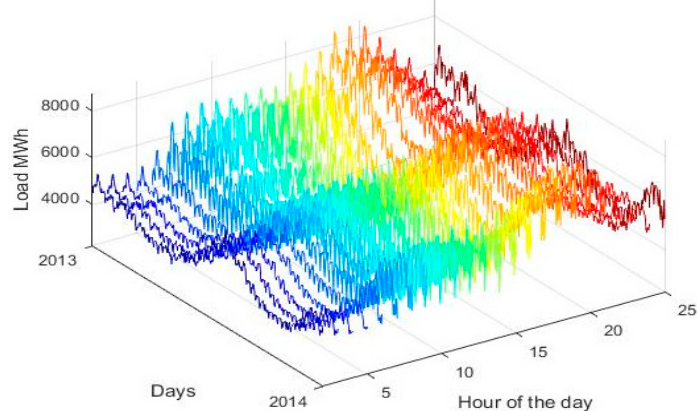
Figure 3. Evolution of load series for each hour of the day, for the year 2013.